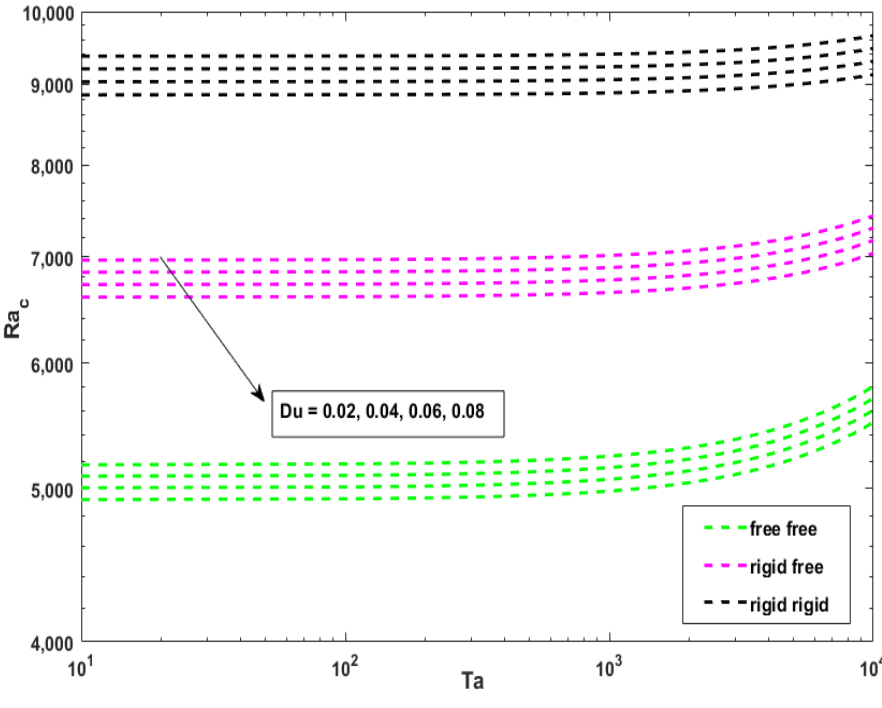
Λ = 8, M = 0.9, φ = 0.9.